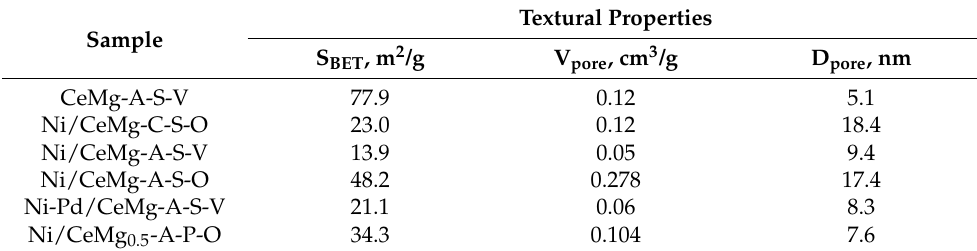
Table 1. Textural properties of the support and as-prepared